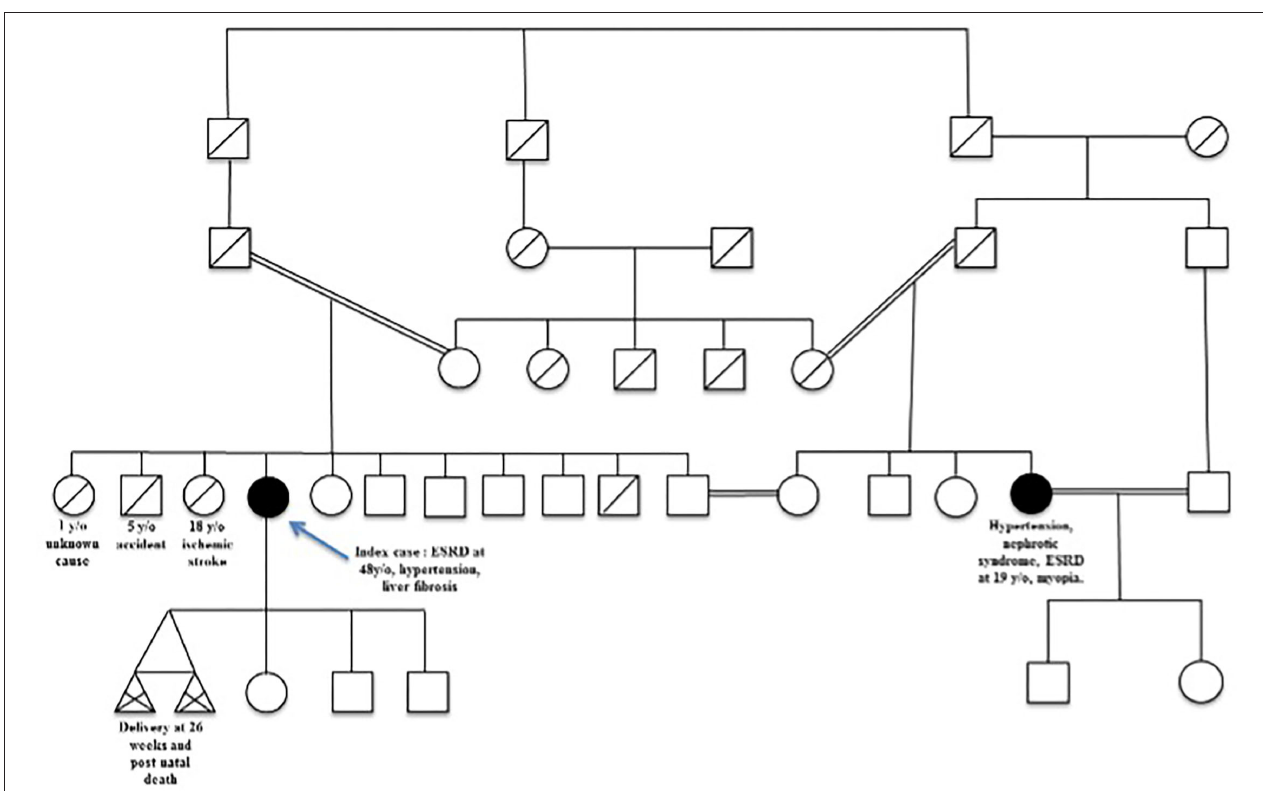
FIGURE 2 | Patient’s familial pedigree. The index case is indicated by the blue